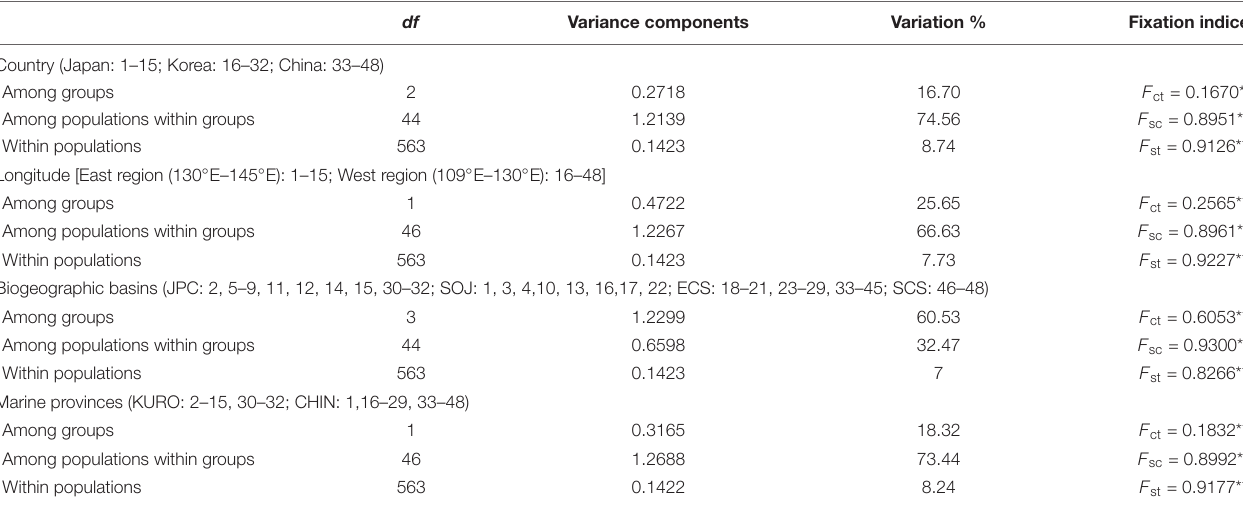
TABLE 2 | Analysis of molecular variance (AMOVA) to partition genetic variance under different grouping criteria. df